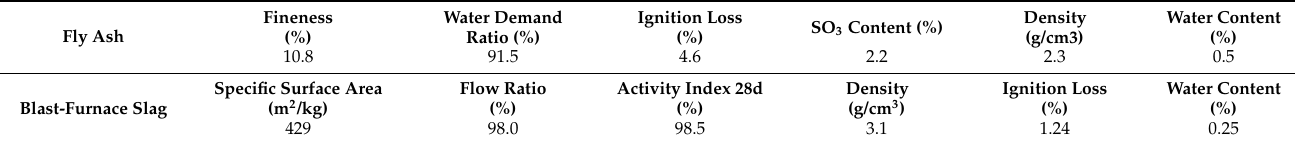
Table 1. The properties of the mineral